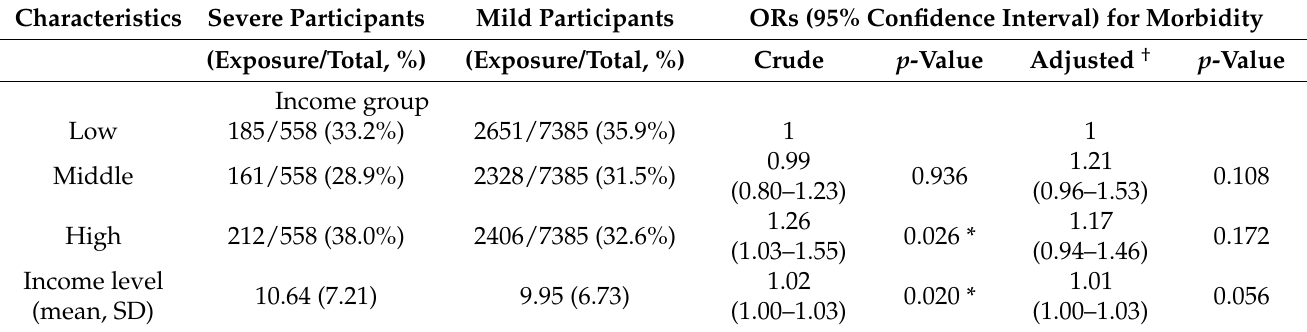
Table 3. Crude and adjusted odds ratios of the association of income with morbidity in COVID-19 participants. Characteristics